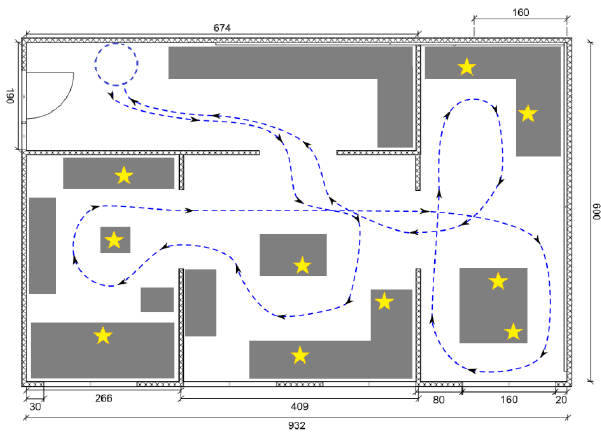
Figure 6. Experiment path (dashed line) and checkpoints